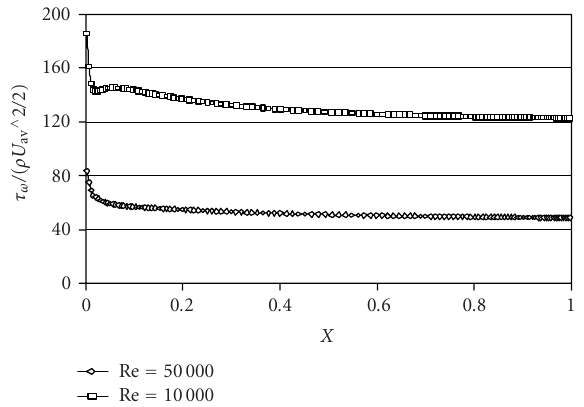
Figure 4: Wall shear stress distribution along the channel wall for ˙ m r = 1 / 1 and Re = 10000 and 50